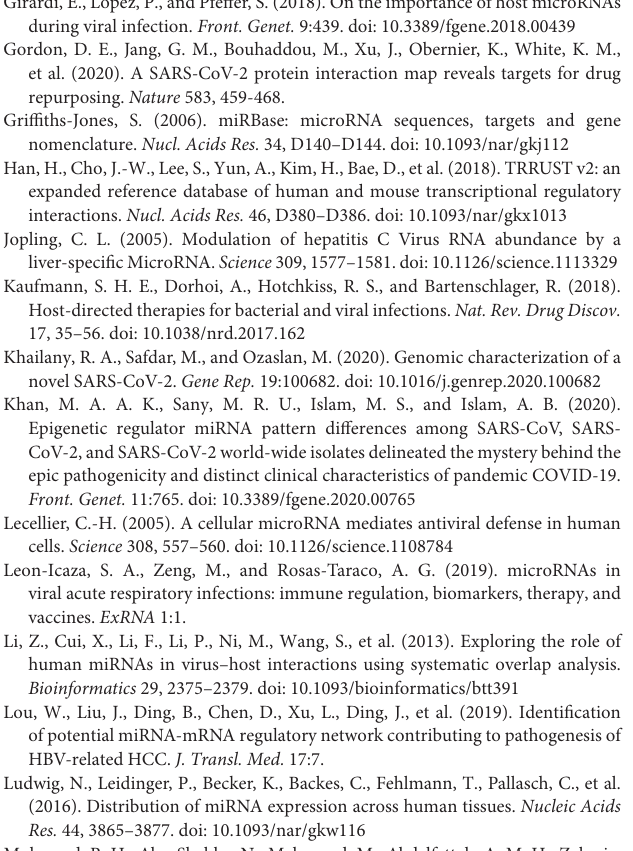
TABLE S5 | Gene expression data of SARS-CoV and SARS-CoV-2. TABLE S6 | miRNA identification in SARS-CoV-2 using miRanda.